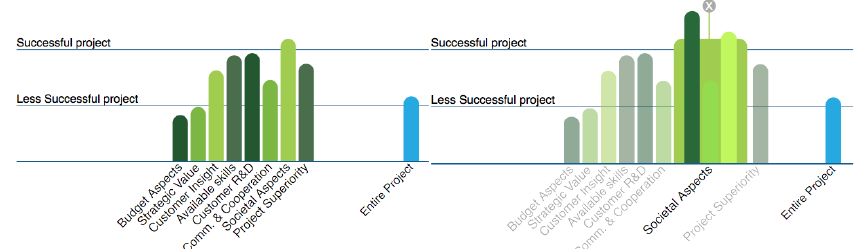
Fig. 1. (L) Scores of a dummy-project on 8 possible KPIs, as described earlier. The weighted average is depicted on the right of the figure. (R) When zooming in on one specific KPI, the dashboard displays the scores of various elements out of which the KPI is constructed. E.g. the KPI ‘Societal Aspects’ consists of 3 elements in this dummy-model. This way, the user gets information on which KPI-specific elements of this KPI are good, and which aspects can be improve